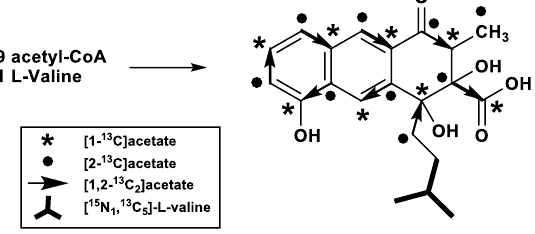
Figure 2. Labelling positions from feeding experiments using different labelled acetates and L -valine.